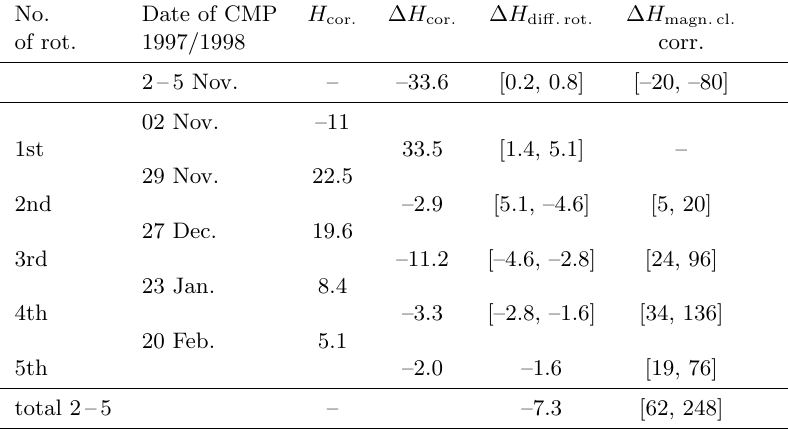
Table 8: The magnetic-helicity budget of AR 8100 is listed per rotation. The evolution of AR 8100 shows two different periods, one during which the AR helicity was negative (Nov. 2 to 5, 1997) and a second one when it was positive (from the second to the fifth rotation). Data for the first rotation are not included because of the uncertainty in the sign of the ejected helicity. An interval of helicity is given for the differential rotation (5th column) to reflect the evolution of the photospheric flux distribution owing to the flux emergence during the first three rotations and for the cloud estimations with the observed number of CMEs (considering the two lengths (0.5 and 2 AU) of the twisted interplanetary flux tube. The budget is discussed in the text. All values are in units of 10 42 Mx 2 . Adapted from Green et al. (2002). No. Date of CMP 𝐻 cor . Δ 𝐻 cor . Δ 𝐻 diff . rot . Δ 𝐻 magn . cl . of